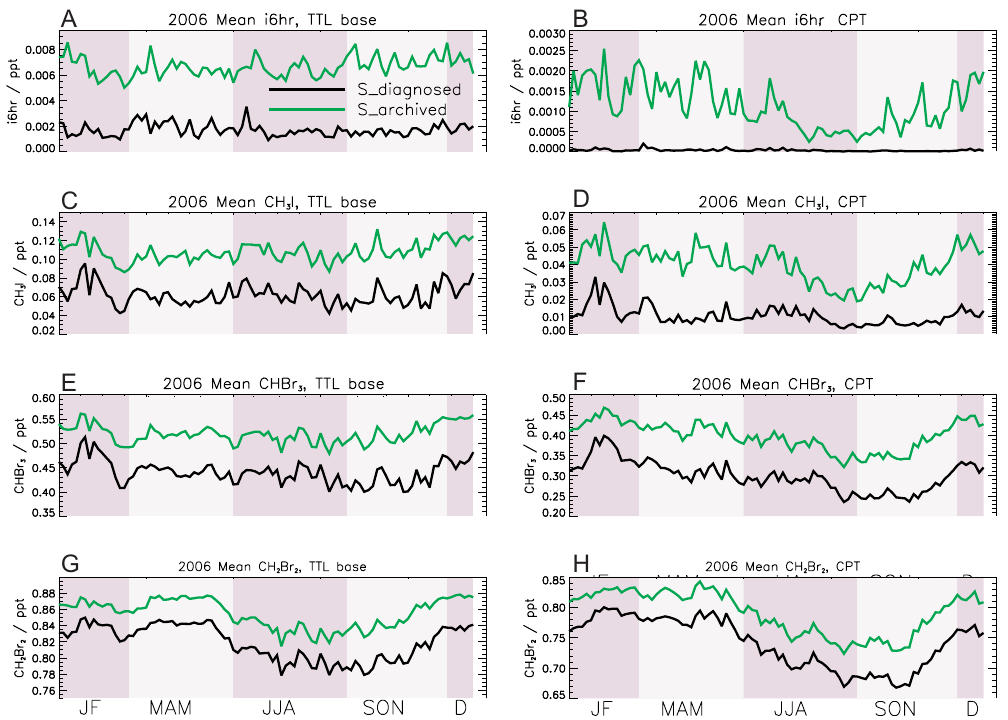
Fig. 3. Zonally averaged volume mixing ratio of (A, B) i6hr, (C, D) CH 3 I, (E, F) CHBr 3 and (G, H) CH 2 Br 2 as a function of time (2006) at the TTL base and the tropical cold point tropopause, respectively, for CTM runs S diagnosed and S archived .